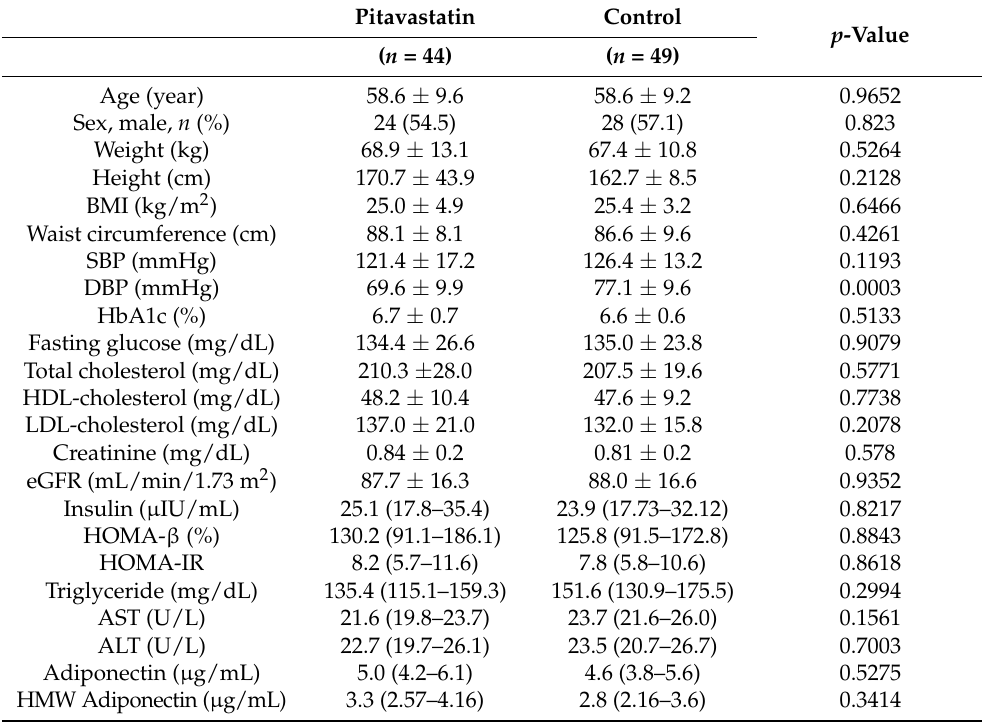
Table 1. Baseline characteristics according to statin